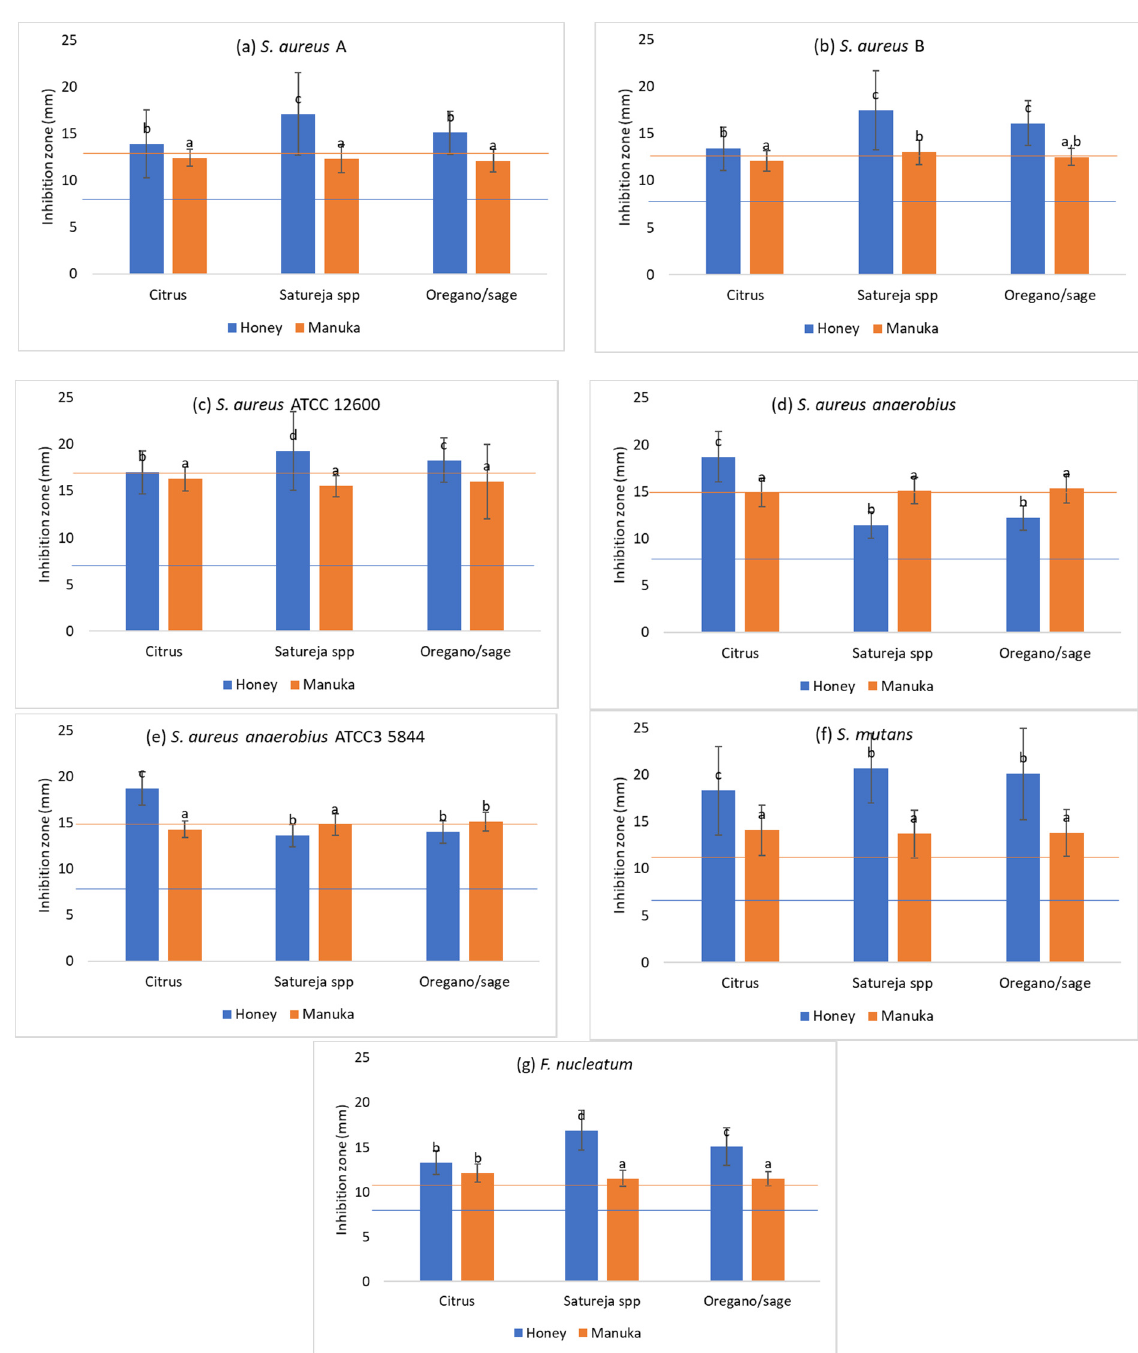
post-hoc comparison) between the honey types of each experiment and for each strain. Different superscript numbers in rows indicate statistically significant differences (ANOVA with Tukey’s HSD post-hoc comparison) for each honey within the various experiments (well diffusion assay, MIC with diluted honey, MIC with artificial saliva).